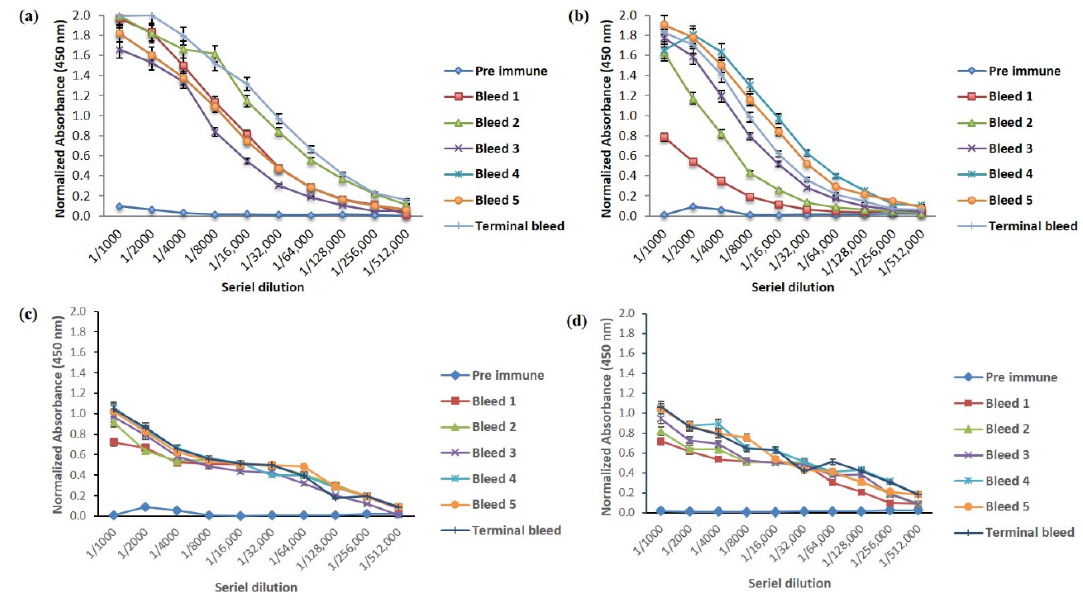
Figure 1. Titers of rabbit antiserum immunized with peptide-KLH; ( a ) rabbit 1, Nter-KLH; ( b ) rabbit 2, Nter-KLH; ( c ) rabbit 1, Cter-KLH; ( d ) rabbit 2, Cter-KLH.